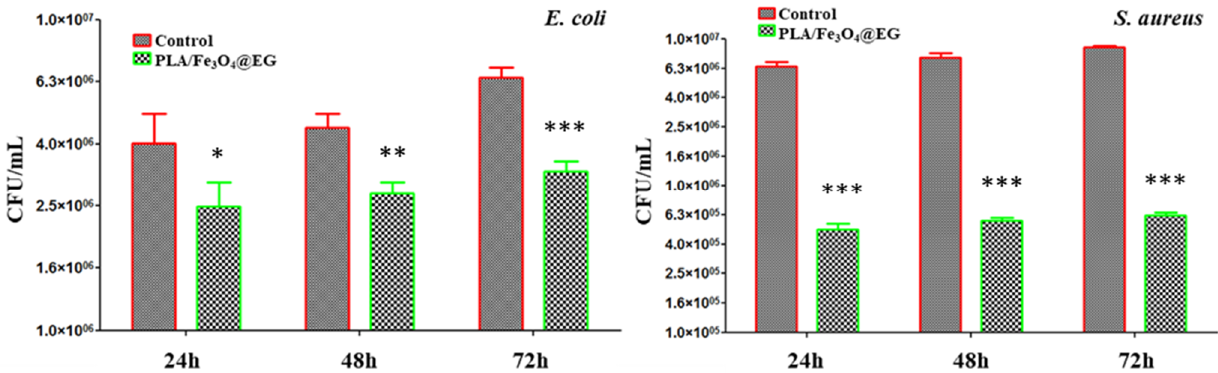
Figure 11. Microbial biofilm development of E. coli ( left ) and S. aureus ( right ) after different incubation periods with PLA/Fe 3 O 4 @EG coatings, expressed as CFU/mL values reflecting number of viable cells imbedded in biofilms. * p < 0.05; ** p < 0.01; *** p < 0.001 (CFU/mL values of control vs. PLA/Fe 3 O 4 @EG coatings).